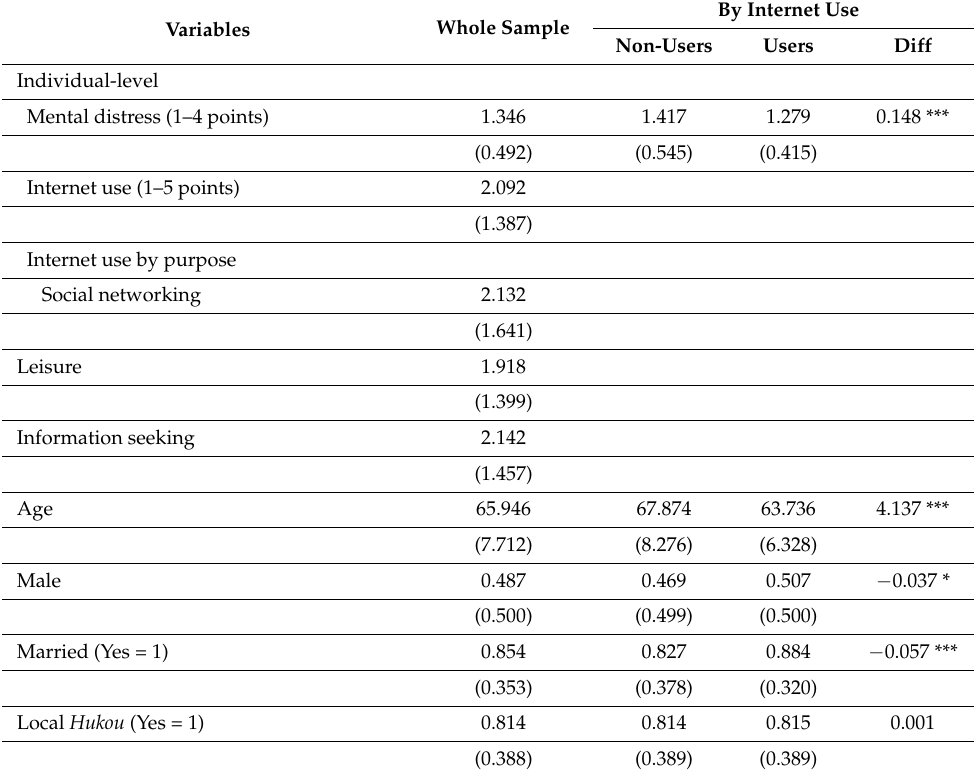
Table 1. Descriptive statistics of older adults in Shanghai: SUNS 2016/17. Variables Whole